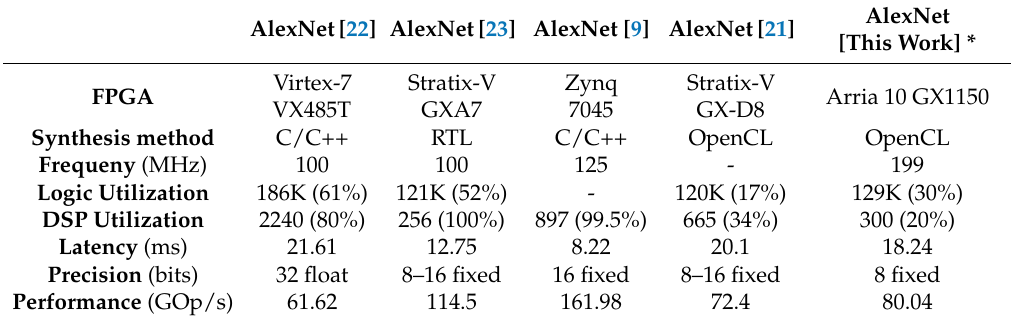
Table 3. Comparison to the existing works AlexNet with hardware options ( N i , N l ) = ( 16,32